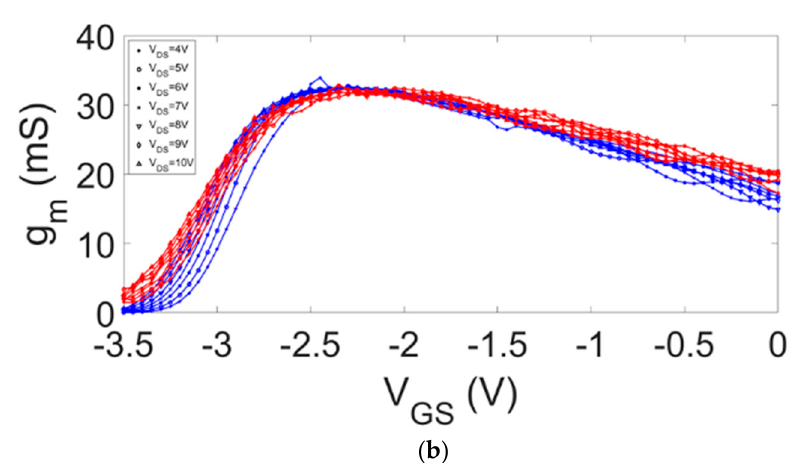
Figure 6. ( a ) I DS and ( b ) g m versus V GS with V DS from 4 V to 10 V (step 1 V) measured for the 100 µm HEMT without (blue line) and with (red line) laser exposure.